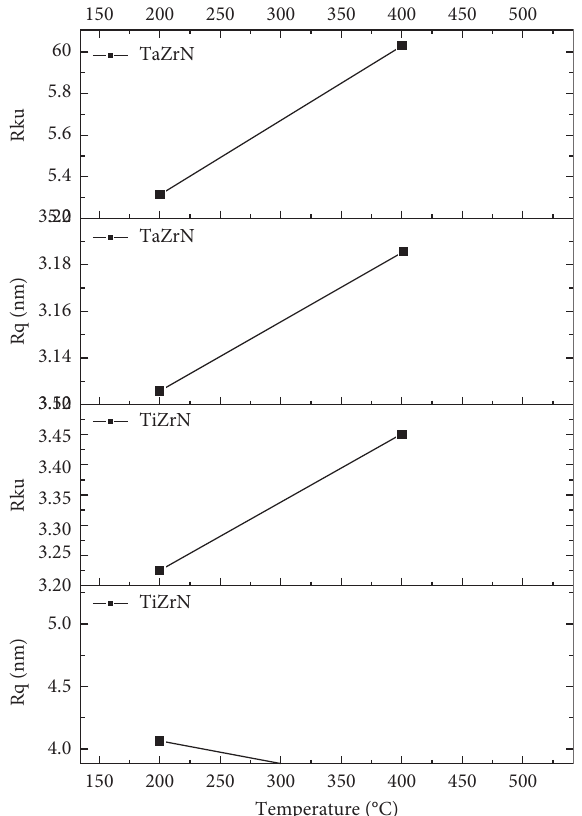
Figure 4: Temperature vs root mean square (Rq) and smooth coefficient